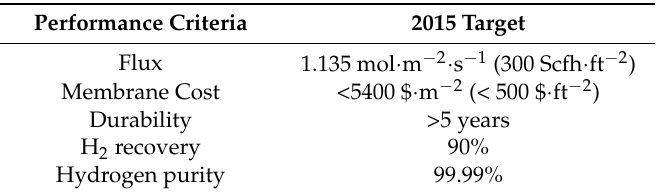
Table 3. US DOE 2015 target for hydrogen separation membranes